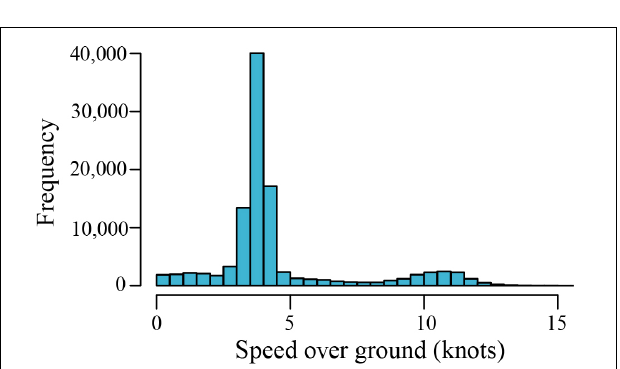
FIGURE 1 | Estimated (reconstructed) catch by foreign and domestic fishing vessels in Somalia’s exclusive economic zone, 1981–2014. Domestic catch reconstruction by Cashion et al. (2018).